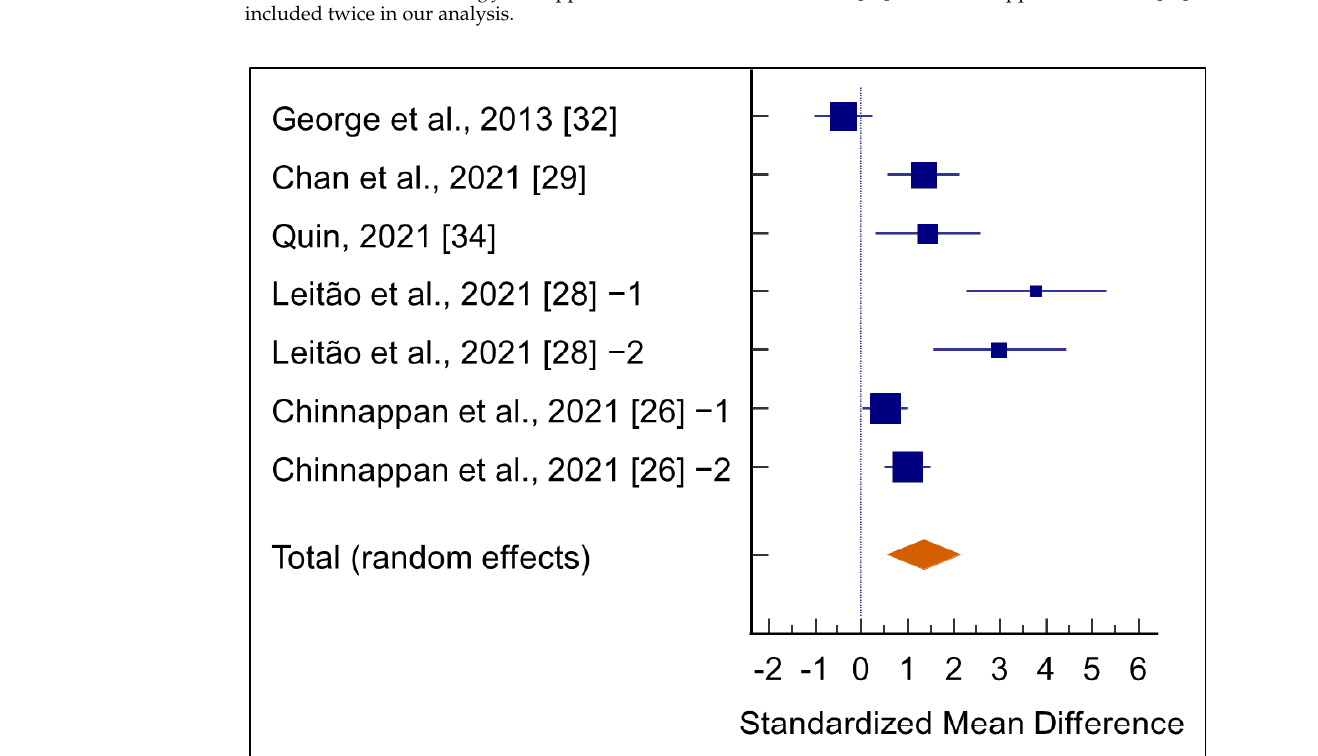
Figure 3. Average net change in serum testosterone levels of men supplemented with Eurycoma longifolia . The pooled effect size is indicated by the diamond. As different groups were analyzed in their studies after E. longifolia supplementation, Leitão et al., 2021 [28], and Chinnappan et al., 2021 [26], are included twice in our analysis. Table 2. Meta-analysis of the outcome variable testosterone in serum.